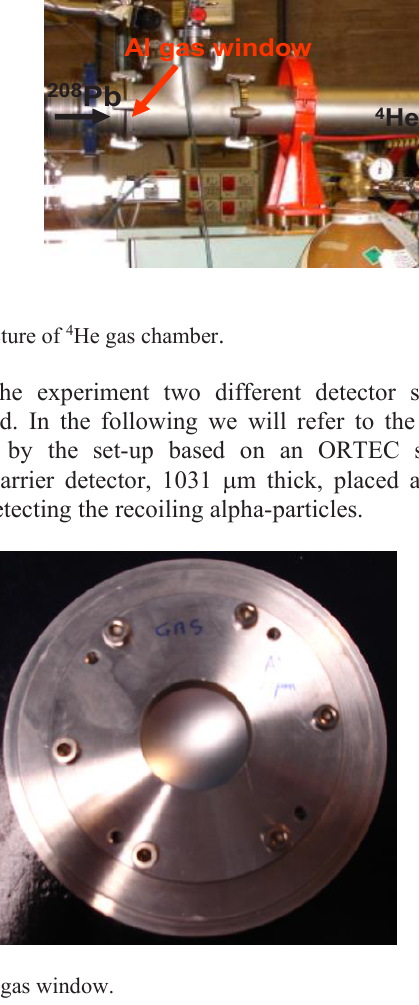
Fig. 4. Al gas window.